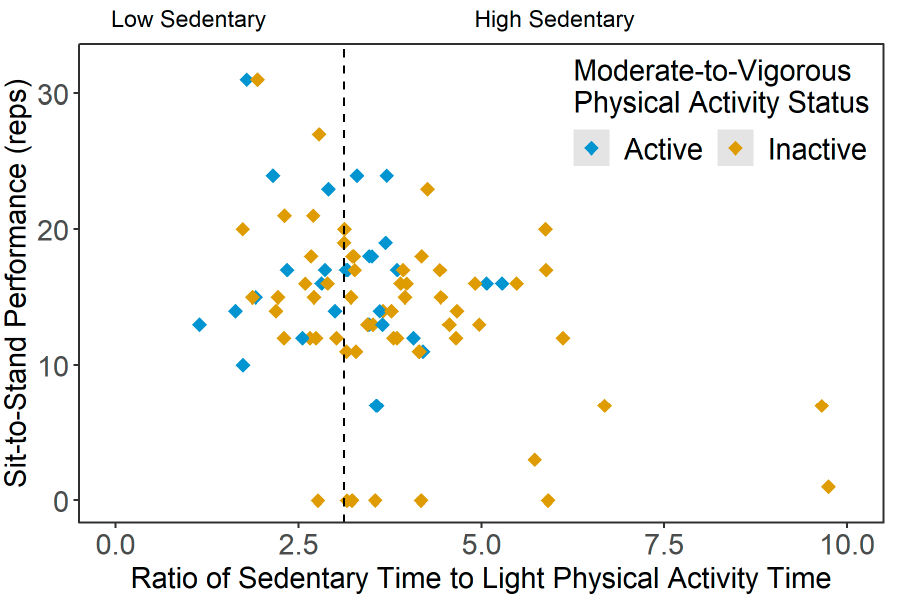
Figure 5. Scatterplot of dynamic balance scores (sit-to-stand scores, reps) across the ratio of average sedentary time and average light physical activity time results, stratified by moderate-to-vigorous physical activity (MVPA) status (active = meeting 150 min/week of moderate-to-vigorous PA (MVPA), inactive = not meeting 150 min/week of